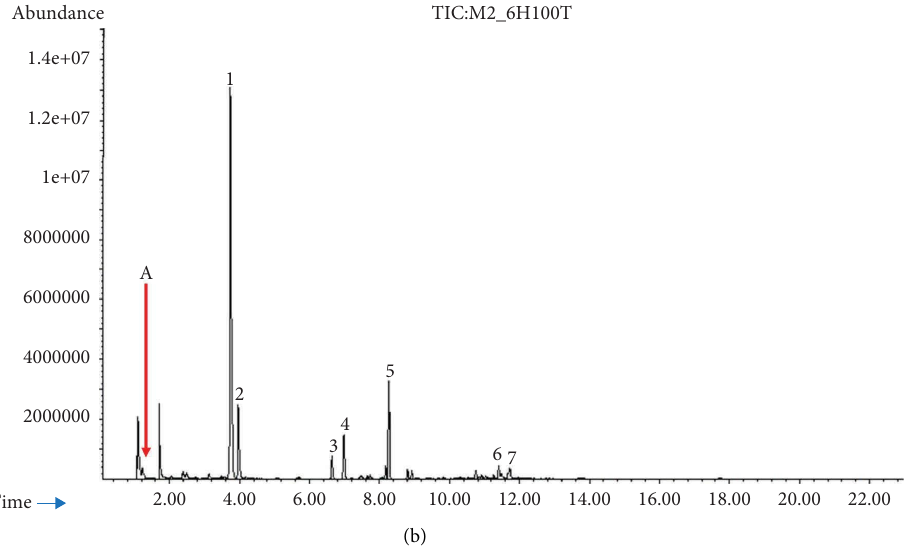
Figure 4: GC-MS chromatographic profles of seven selected terpenes in essential oils from the immature (a) and mature (b) leaves at 0 − 6 hrs of hydrodistillation: (A) internal standard (100 μ g/mL thiophene), (1) camphor, (2) L-borneol, (3) silphiperfol-5-ene, (4) 7-epi-sil- phiperfol-5-ene, (5) caryophyllene, (6) ɤ -eudesmol, and (7) α